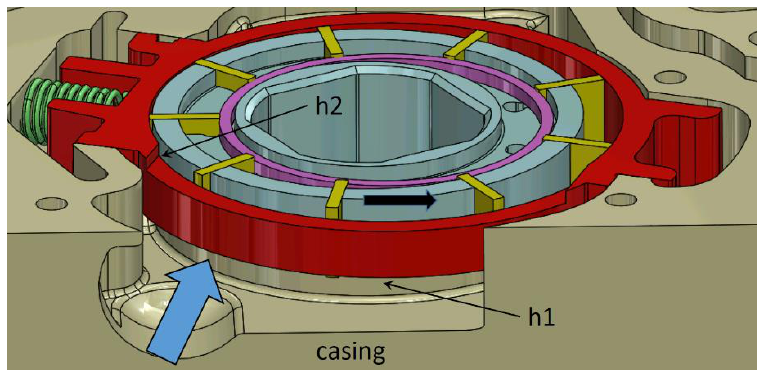
Figure 3. View of the pump from the inlet pipe with the indication of the direction of the flow, the location of the cuttings h1 and h2, and the direction of rotation (black arrow). Table 1. Geometric parameters for each analyzed